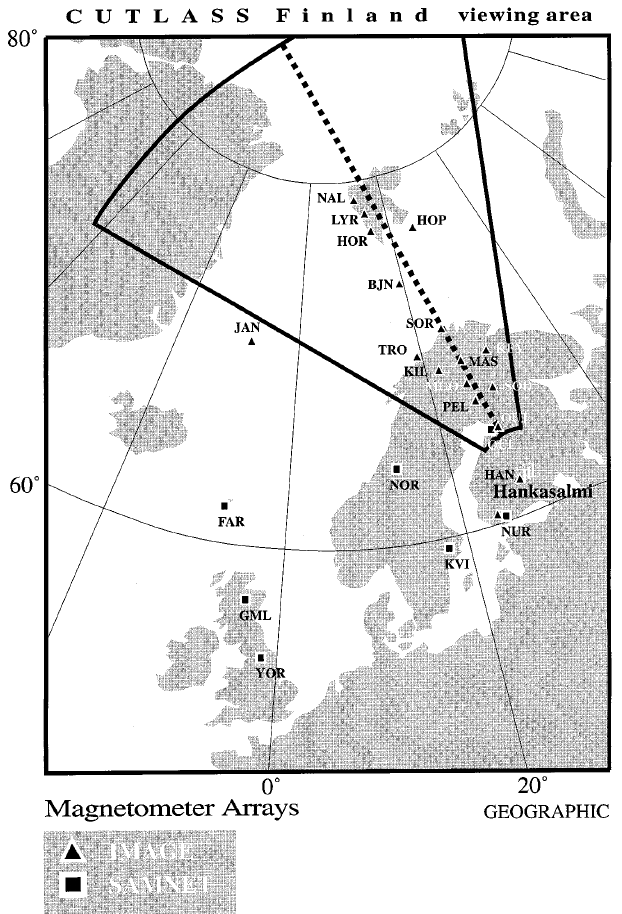
Fig. 1. Locations of the field-of-view of the CUTLASS Finland radar together with the IMAGE and SAMNET magnetometer stations used in this study. Beam 9 of CUTLASS Finland, which is sampled at a high rate, is marked by a dashed